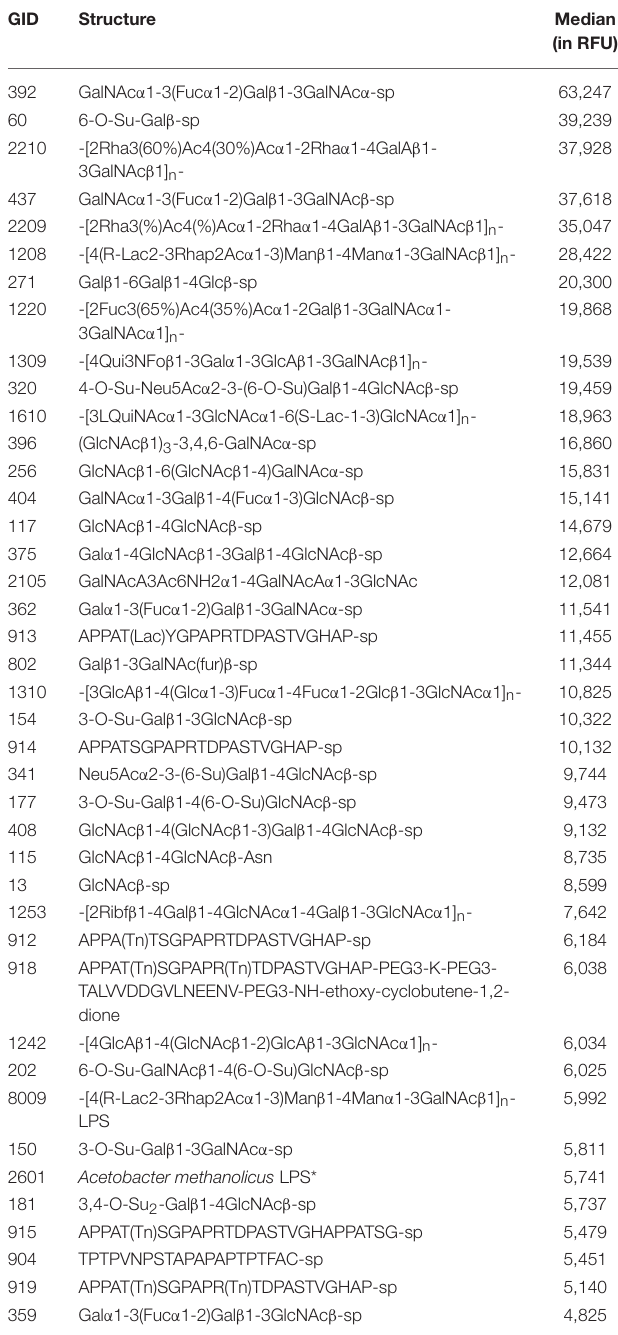
TABLE 2 | GalT-KO mice gain diversity in the repertoire of natural anti-carbohydrate antibodies from month 2 of life. GID